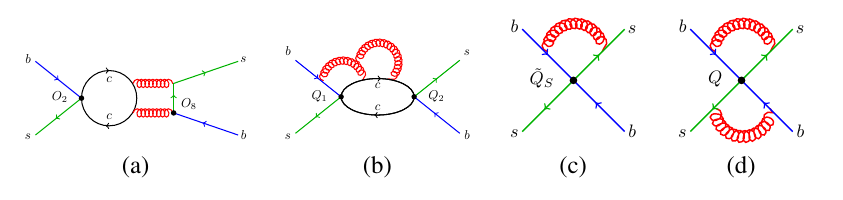
Figure 1. Some of the Here (a) and (b) denote and (d) represent 1- and 2-loop matrix elements of